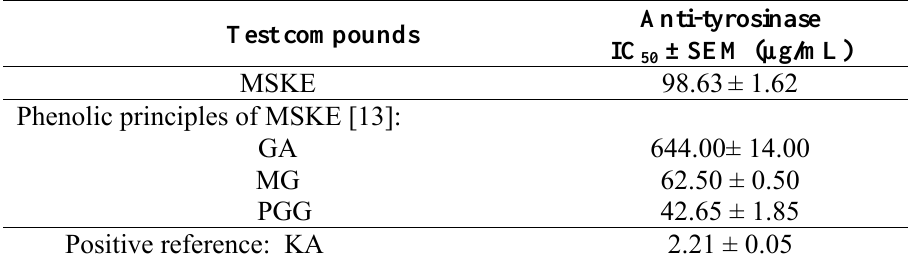
Table 1. Tyrosinase inhibitory activity of MSKE and its phenolic principles compared with the positive reference,